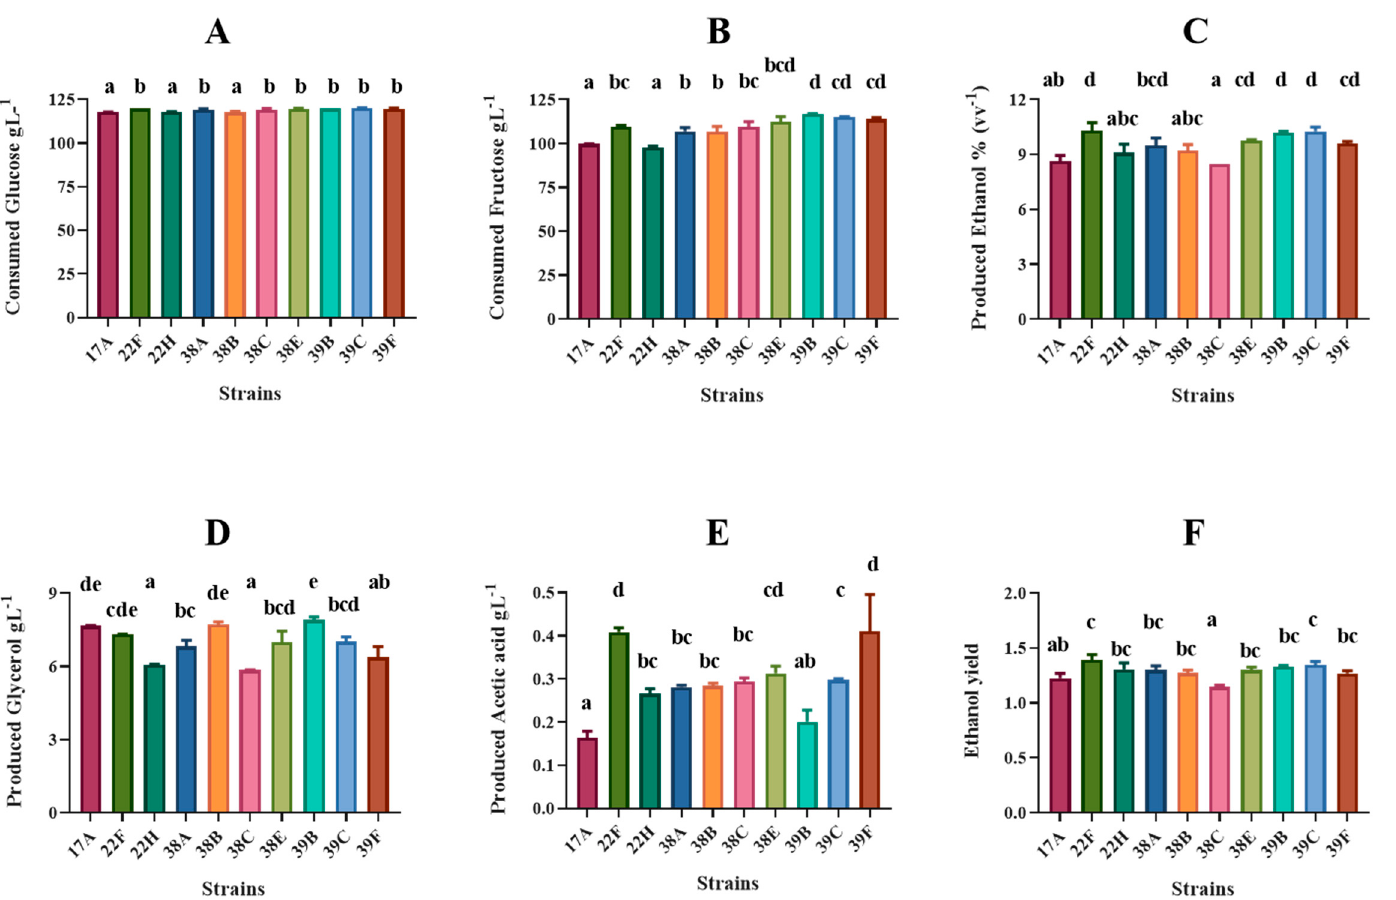
Figure 3. Consumed sugars, products generated, and ethanol yield from sugars on day 14 from the start of yeast inoculation. Glucose consumption expressed as g/L ( A ), fructose consumption expressed as g/L ( B ), ethanol production expressed as % ( v / v ) ( C ), glycerol production expressed as g/L ( D ), acetic acid production expressed as g/L ( E ), and ethanol yield ( F ). Different letters in the columns mean a significant difference ( p < 0.01) between the values.